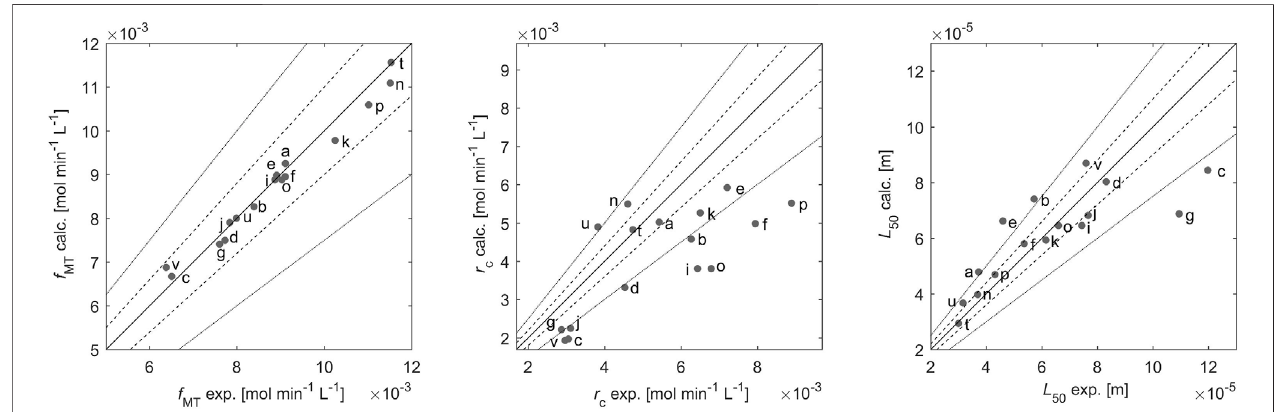
FIGURE 2 | The experimental values und the modelling results of the CO 2 absorption rate f MT , the CaCO 3 precipitation rate r C and the volume weighted average particle size L 50 are visualized in parity plots.